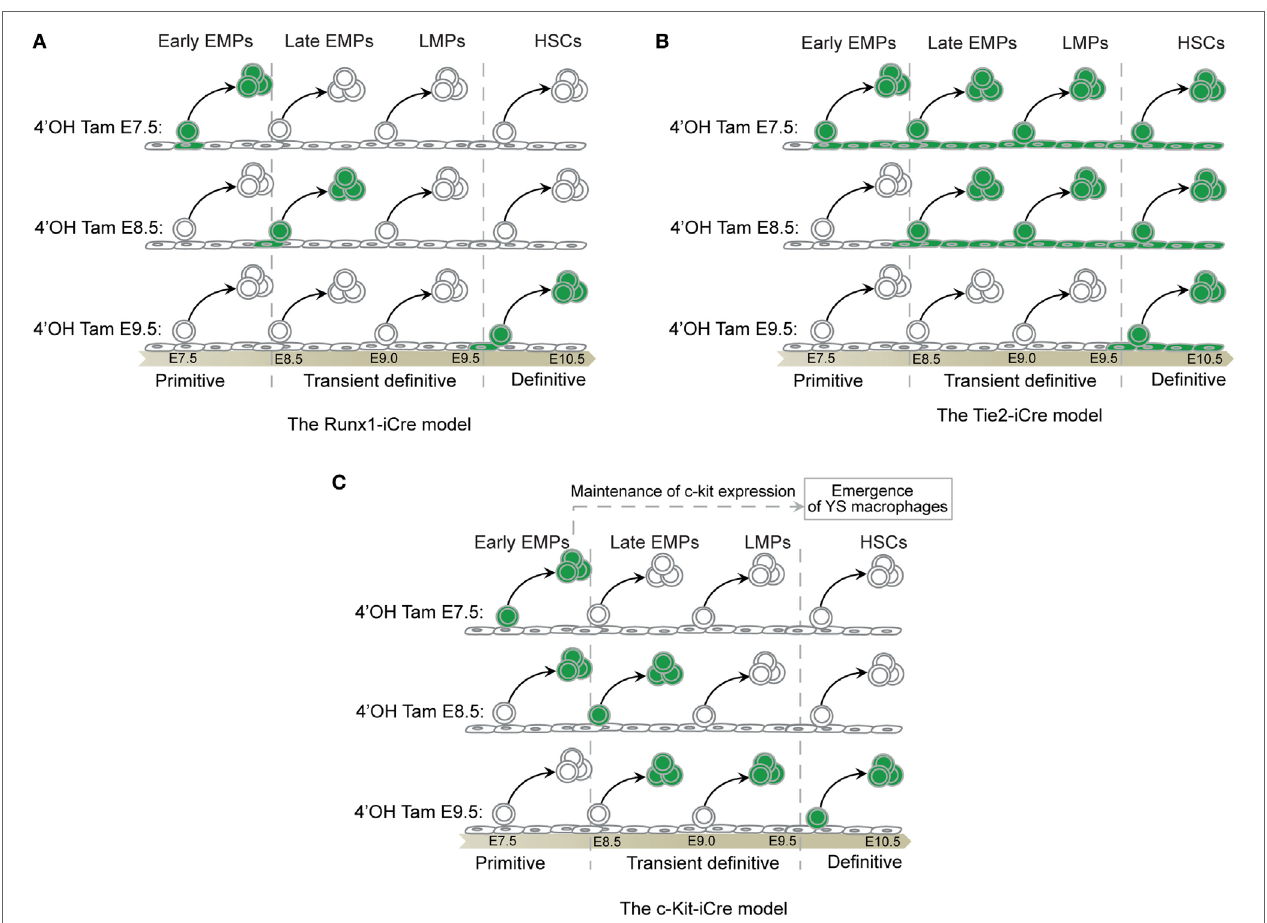
FiGURe 6 | Fate-mapping systems . (A) The Runx-iCre fate-mapping model (86) used in our study targets the hemogenic transition (88), hence, labeling specifically progenitors in the process of budding out from the hemogenic endothelium. The Runx1 expression decreases in progenitors once they start to express Vav thus reducing the chances of tagging released progenitors from precedent waves (88). As a consequence, Runx-iCre tagging is restricted to a short time window in the lifespan of a given progenitor and allows a sharp definition of each hematopoietic wave. However, this model also restricts the tagging to only a small fraction of the targeted progenitor wave. (B) Tie2 is expressed in all endothelial cells that constitute the hemogenic endothelia even before the hemogenic transition (89). Thus, all endothelial cells and their progeny (non-hematopoietic and hematopoietic cells) will be labeled after tamoxifen injection using the Tie2-iCre model. As a consequence, an early tamoxifen injection (such as at E7.5) will result in the tagging of all hematopoietic cells emerging before the time of analysis. This will include progenitors from the primitive, the transient definitive, and the definitive waves if, for example, the analysis is done at E11.5. A late injection (such as at E10.5) will restrict the tagging to only the latest hematopoietic stem cells wave as they are just budding from HEs (90). Thus, this model might not be suitable to clearly separate the primitive from the transient definitive waves of hematopoiesis. However, this model could be important to study late HSC progeny as no other progenitors than HSCs emerge from HE after E10.5 (91). (C) C-kit is expressed by all hematopoietic progenitors and does not label endothelial cells that constitute the HEs (89). An early tamoxifen injection (such as at E7.5) will restrict the labeling to early progenitors making suitable the c-kit-iCre model to study the primitive hematopoiesis. However, the FL recruits progenitors of each hematopoietic wave from E8.5 until E11 (79). These progenitors still express c-kit and coexist after seeding the FL during the time necessary for their differentiation (47, 55). A later tamoxifen injection (such as at E9.5) might thus result in the cumulative labeling